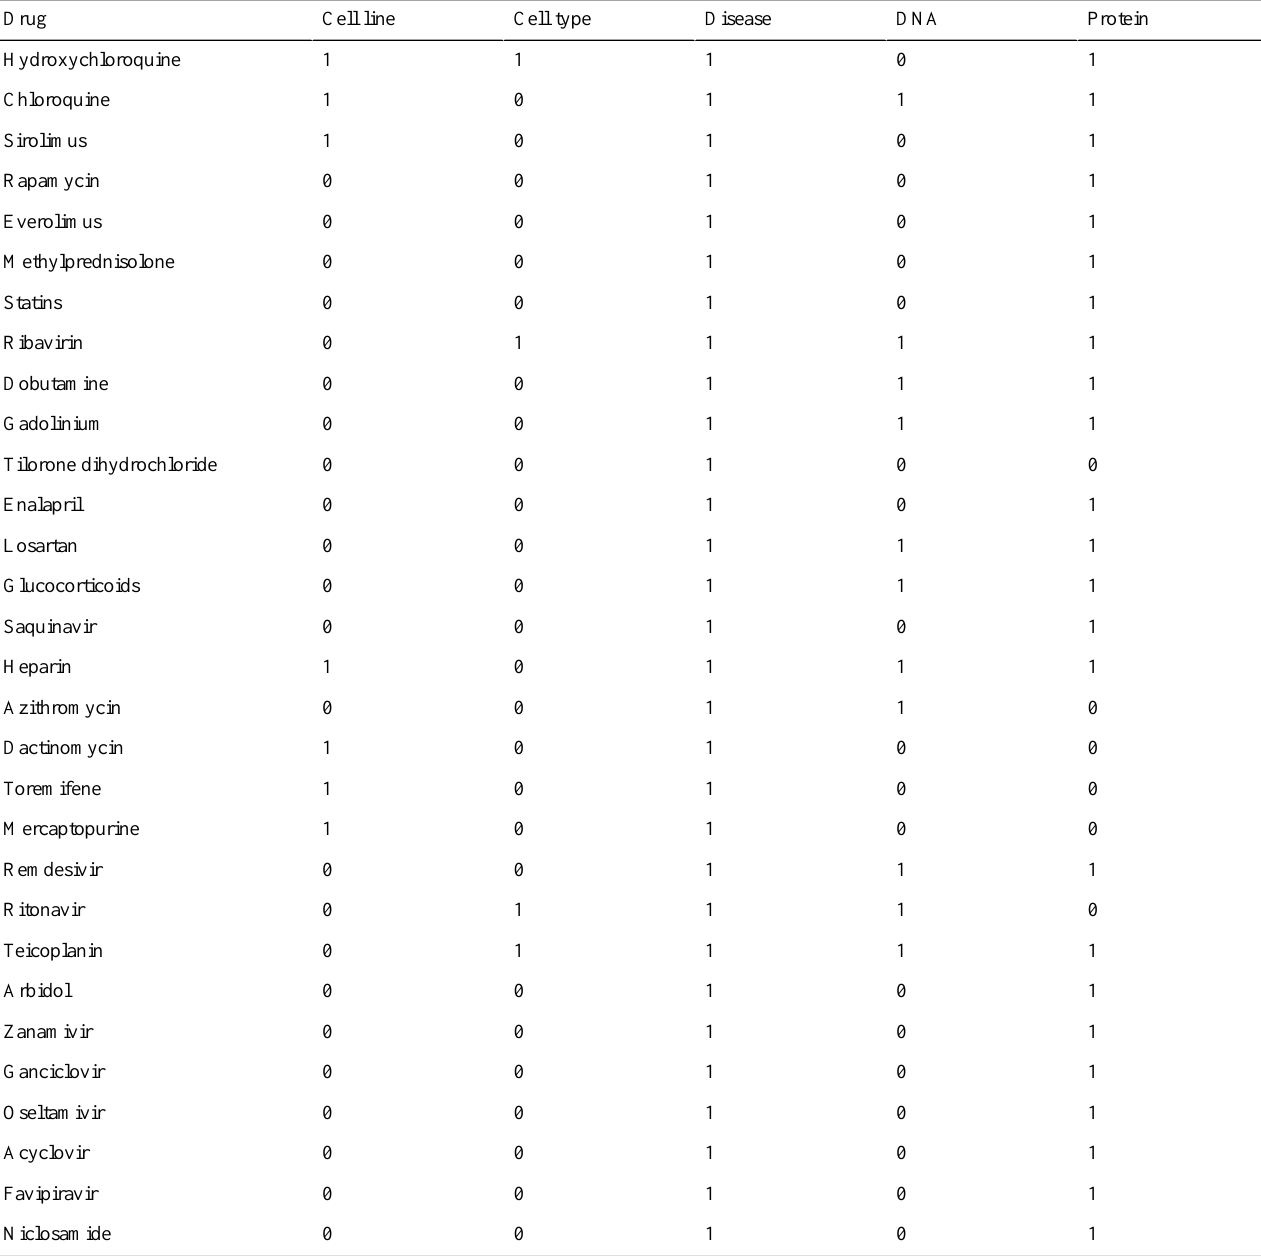
Table 1. Summary of the binary matrix of drugs-entity resulted from the natural language procressing. a